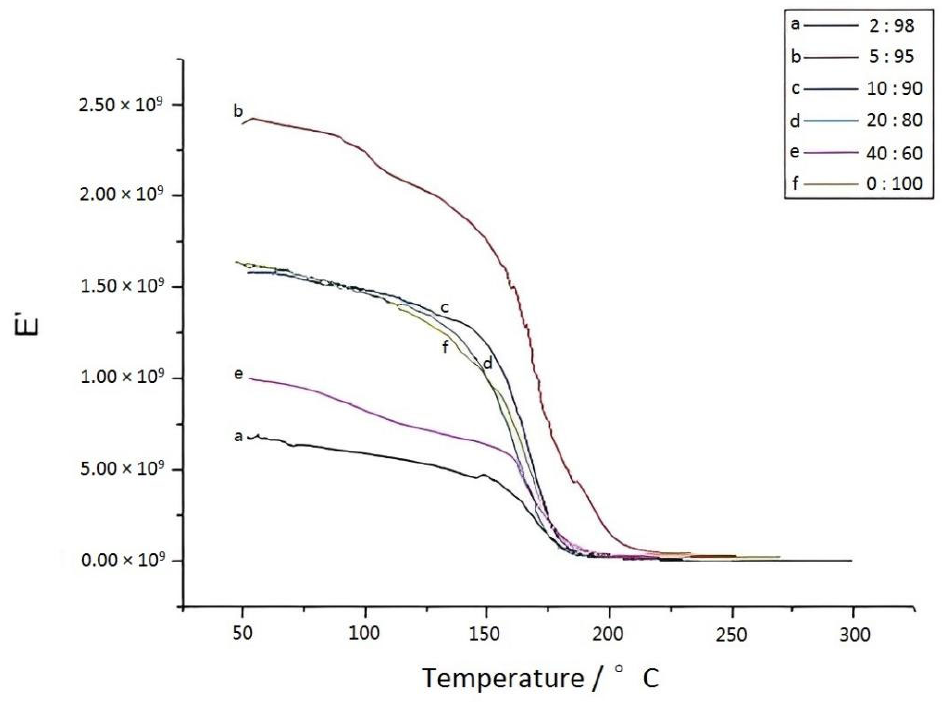
Figure 16. Plots of temperature versus storage modulus for BZ composite material with different eugenol–furfuryl amine content.